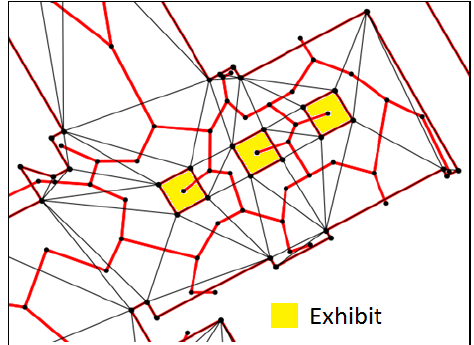
Figure 3. Extracted